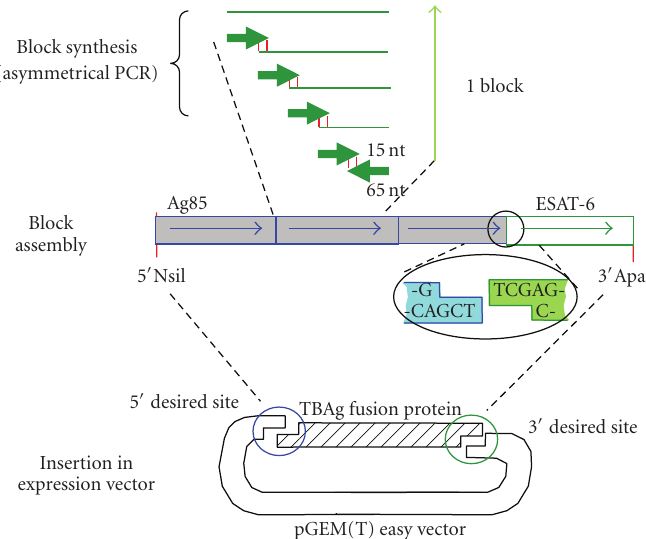
Figure 1: Diagrammatic representation of the Ag85B/ESAT-6 fusion cassette. The strategy used was recursive asymmetric PCR. In silico modified Ag85B and ESAT-6 gene sequences were divided into 3 blocks (267, 308, and 314 nt) for Ag85B and one (314nt) for ESAT-6. Each block was created by asymmetric PCR using five 65 to 70-mer primers then cloned into pGEM(T)-easy. Blocks were flanked by “suicidal” restriction sites to allow further assembly of the full-length cassette. Nsi I and Apa I restriction sites were created upstream and downstream, respectively, to allow cloning into the pGEM(T)-easy and removal of the whole TBAg